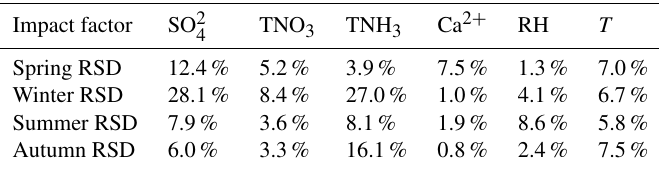
Table 2. Sensitivity of PM 2 . 5 pH to SO 2 , TNH 3 , TNO 3 , Ca 2 + , RH, and T . A larger magnitude of the relative standard deviation (RSD) 4 represents a larger impact derived from variations in